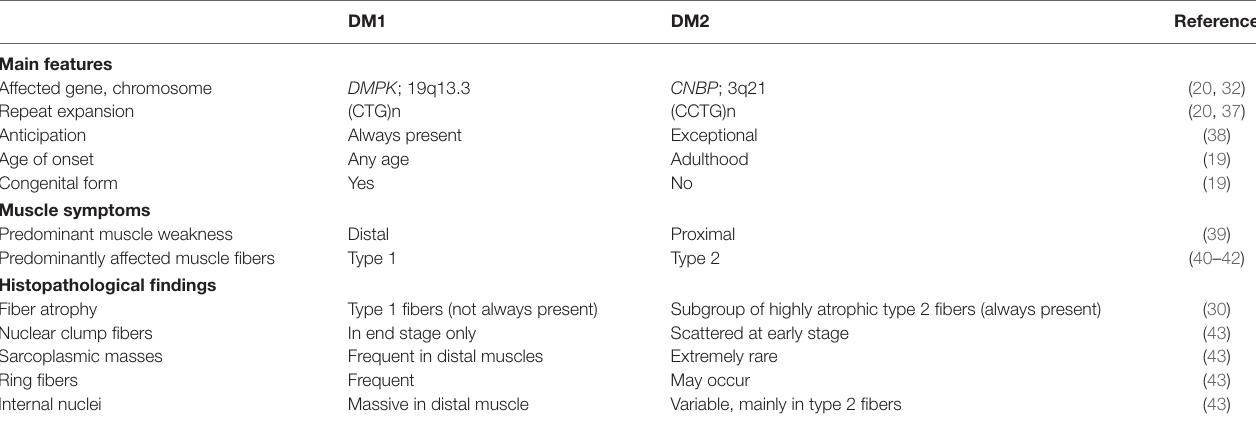
TAble 1 | Similarities and differences in genetic, clinical, and histopathological features of myotonic dystrophy type 1 (DM1) and myotonic dystrophy type 2 (DM2). DM1